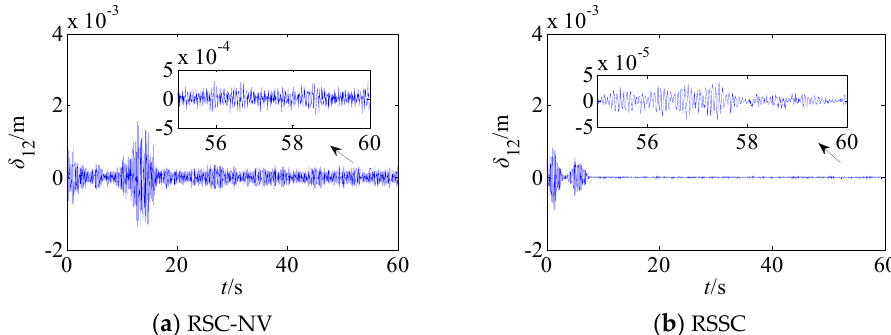
Figure 9. The second mode coordinates of the flexible link B 1 .